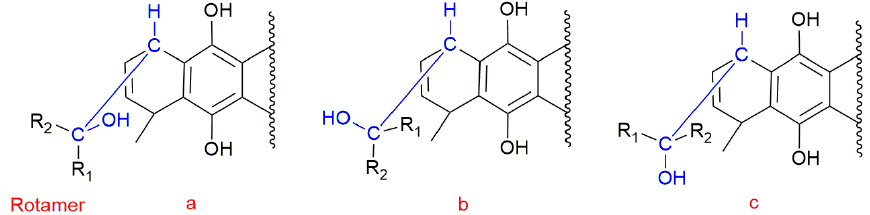
Figure 3. Rotamers generated by rotation of dihedral angle H8(5)-C8(5)-C1 ′ R1R2-OH (molecules 1 to 4 ) or H9(6)-C9(6)-C1 ′ R1R2-OH (molecules 5 and 6 ).